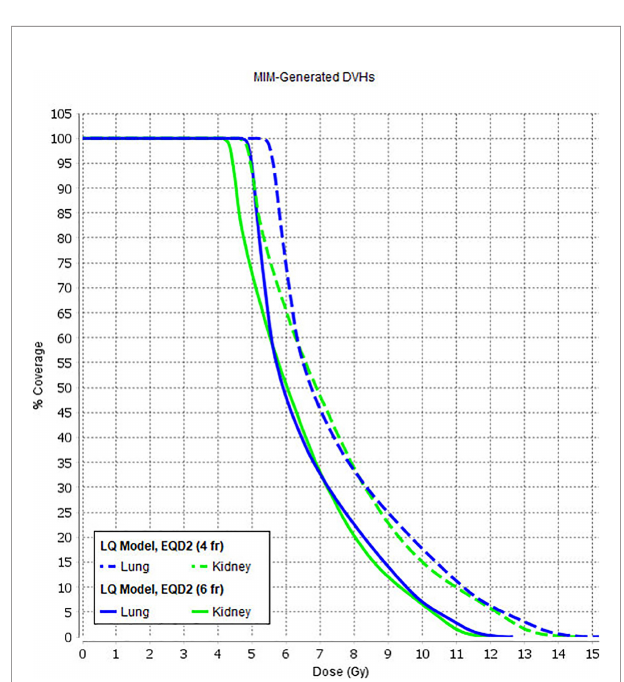
FIGURE 5 | Lung and kidney DVH variations with a linear quadratic model using different alpha/beta